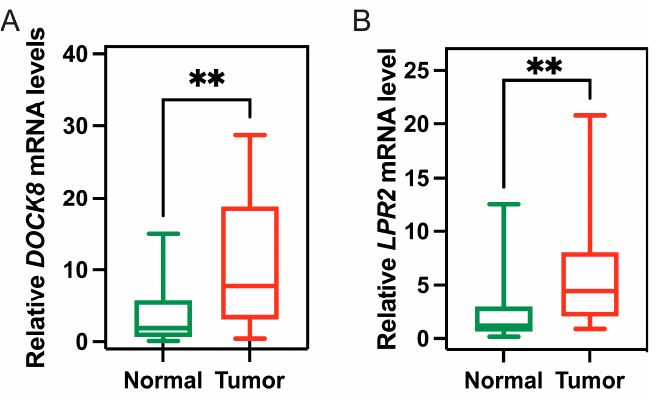
Figure 3. The expression of tumour antigen in clinical tumour patients. The expression of DOCK8 ( A ) and LRP2 ( B ) in tumour and normal tissues of 19 KIRC patients; (** p < 0.01).